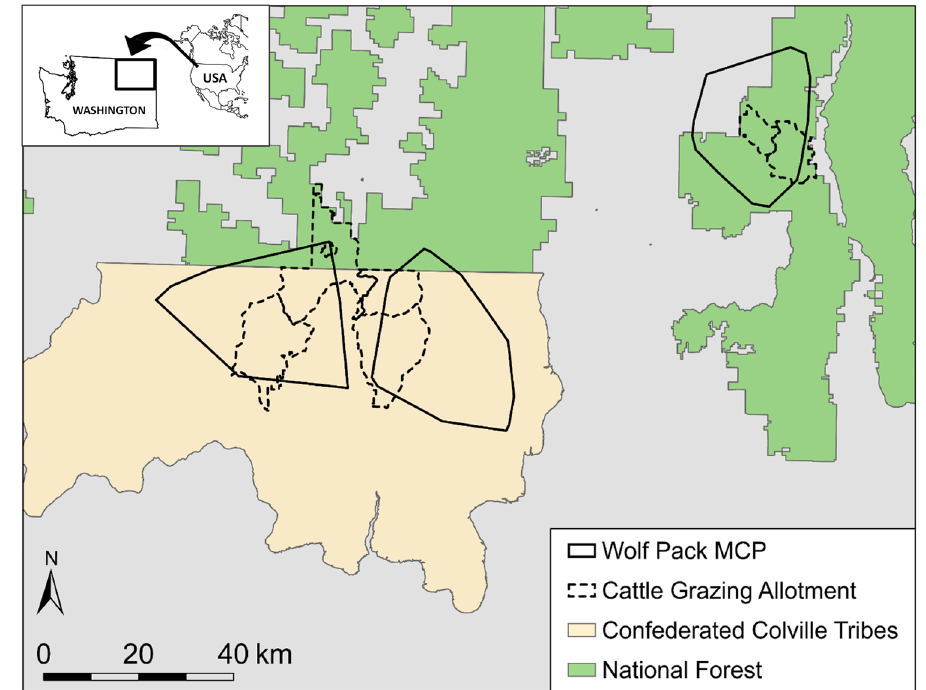
Figure 1. Study area in Northeastern Washington, USA, with minimum convex polygon (MCP) of wolf packs (n = 3) and cattle grazing allotments (n = 6, two allotments per pack) where wolf-cattle interactions were studied in 2014–2016. Map was created in ArcGIS 10.6 (ESRI, Redlands, CA) using data collected during the study and shapefiles provided by the Colville Tribes Fish and Wildlife Department, and Colville National Forest